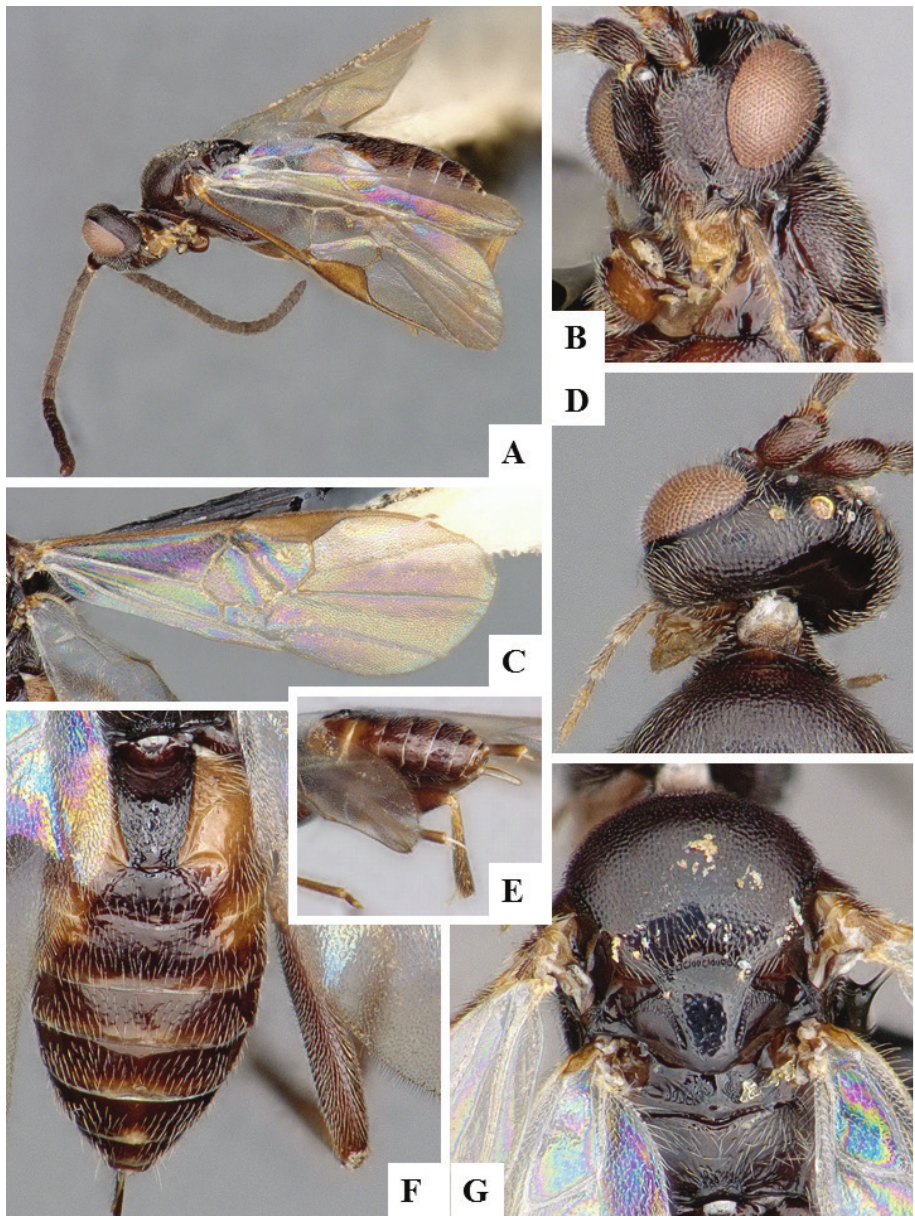
Figure 9. Apanteles morrisi. A Habitus, lateral B Head, frontal C Wings D Head and mesosoma, dorsal E Metasoma dorsal F Head and antenna,